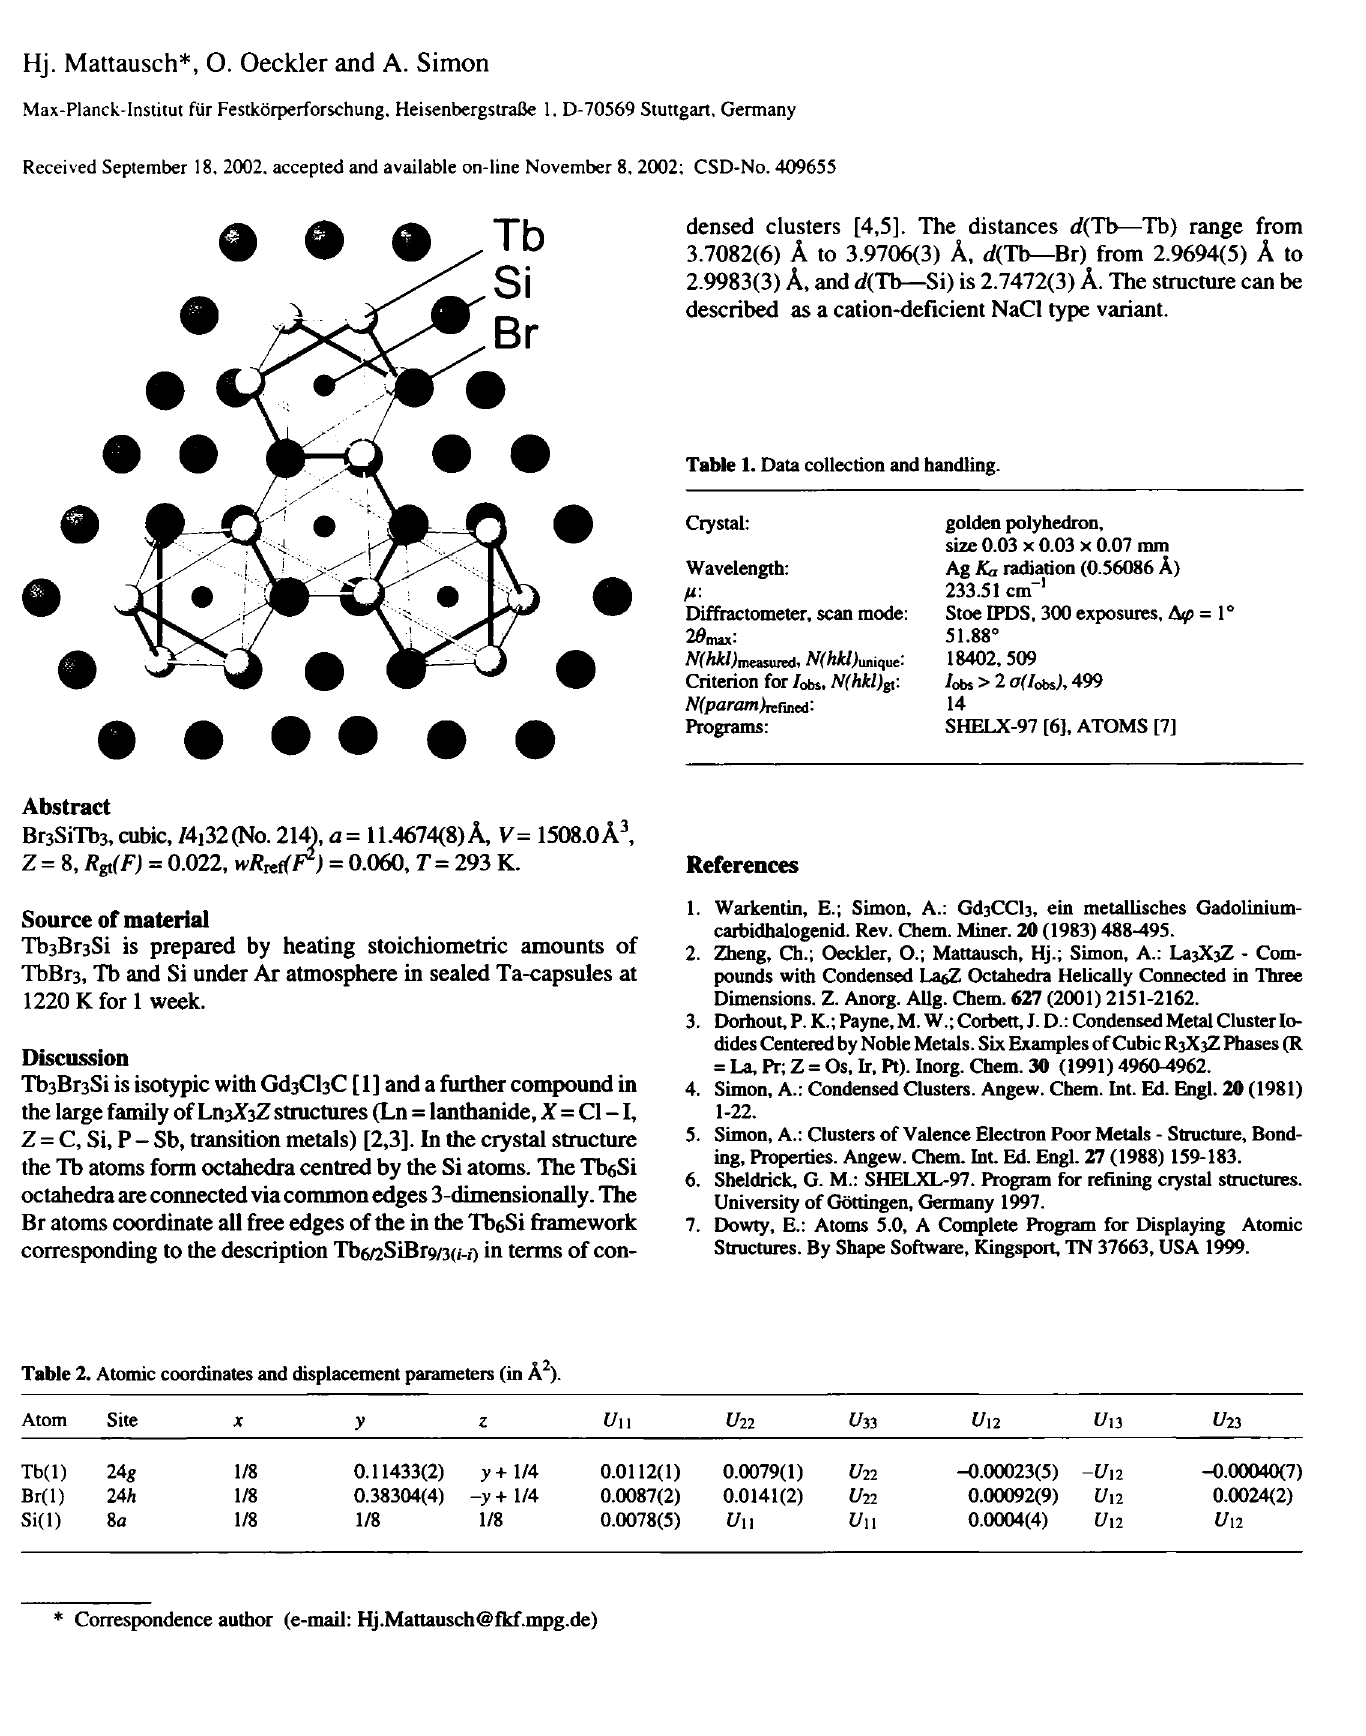
Table 2. Atomic coordinates and displacement parameters (in Â 2